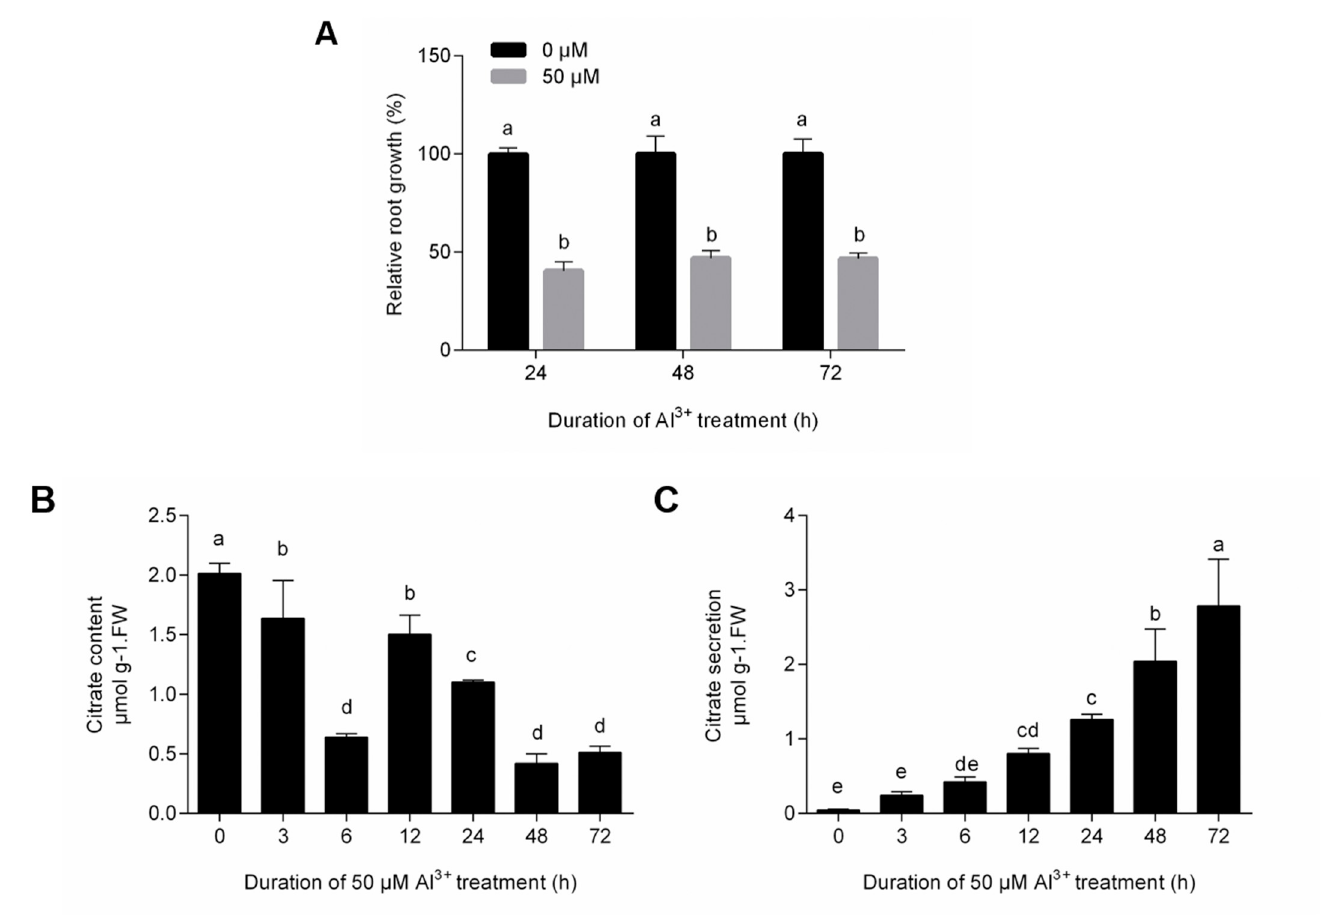
Fig 1. Effect of the Al 3+ treatment on TBS roots. (A) Relative root growth; (B) Citrate content; (C) Citrate secretion. The bars are the means ± standard deviation of three replicates. Different letters above columns indicate significance (Duncan, p < 0.05).